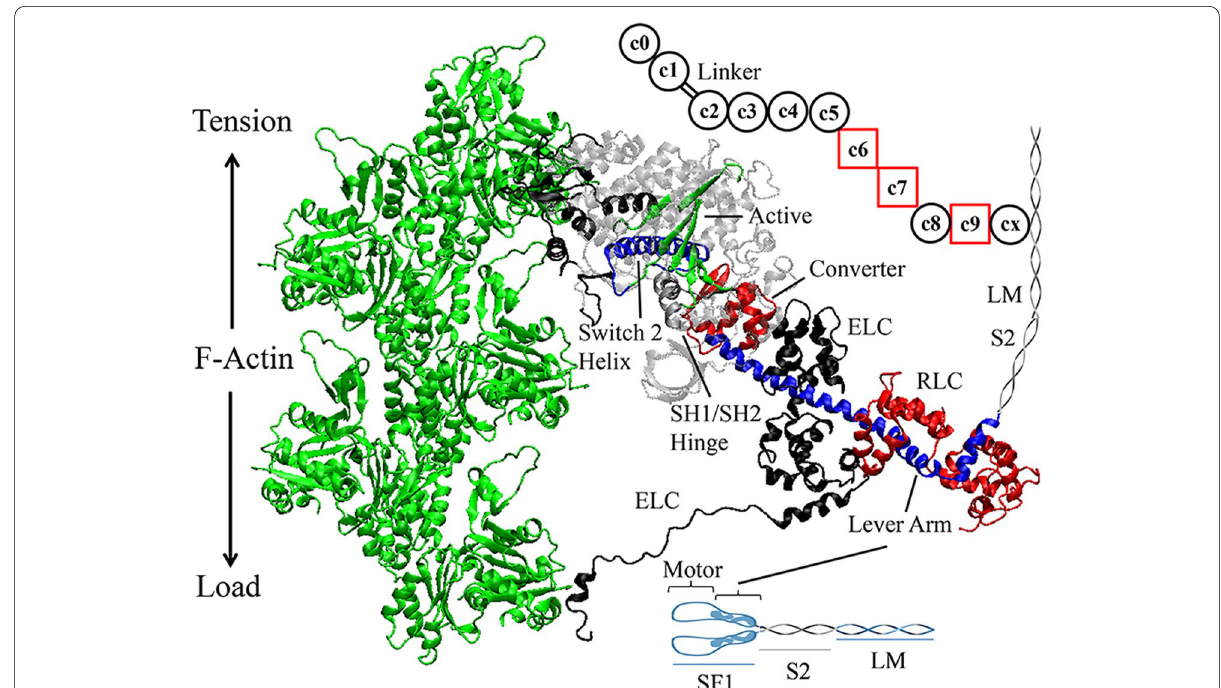
Fig. 1. Myosin and MYBPC3 structures in the sarcomere. Myosin dimer model (bottom right) has two subfragment 1 (SF1), subfragment 2 (S2), and light meromyosin (LM) polypeptides. SF1 crystal structure has a motor domain and a lever arm (blue) with bound light chains ELC (black) and RLC (red). The motor domain contains several binding sites for actin, the active site binding ATP (green), the switch 2 helix (blue), SH1/SH2 hinge (silver), and converter domain (red). MYBPC3 model (upper right) has multiple domains shown schematically in black circles or red squares indicating immunoglobulin-like or fibronectin-like domains with CX binding myosin LM, N-terminal C0-C2 maintaining transient interactions with F-actin (green) and myosin, and the linker containing regulatory phosphorylation sites. Tension and load vectors indicate direction of force generated by myosin and opposed by F-actin, respectively. F-actin and SF1 homology models were obtained as described